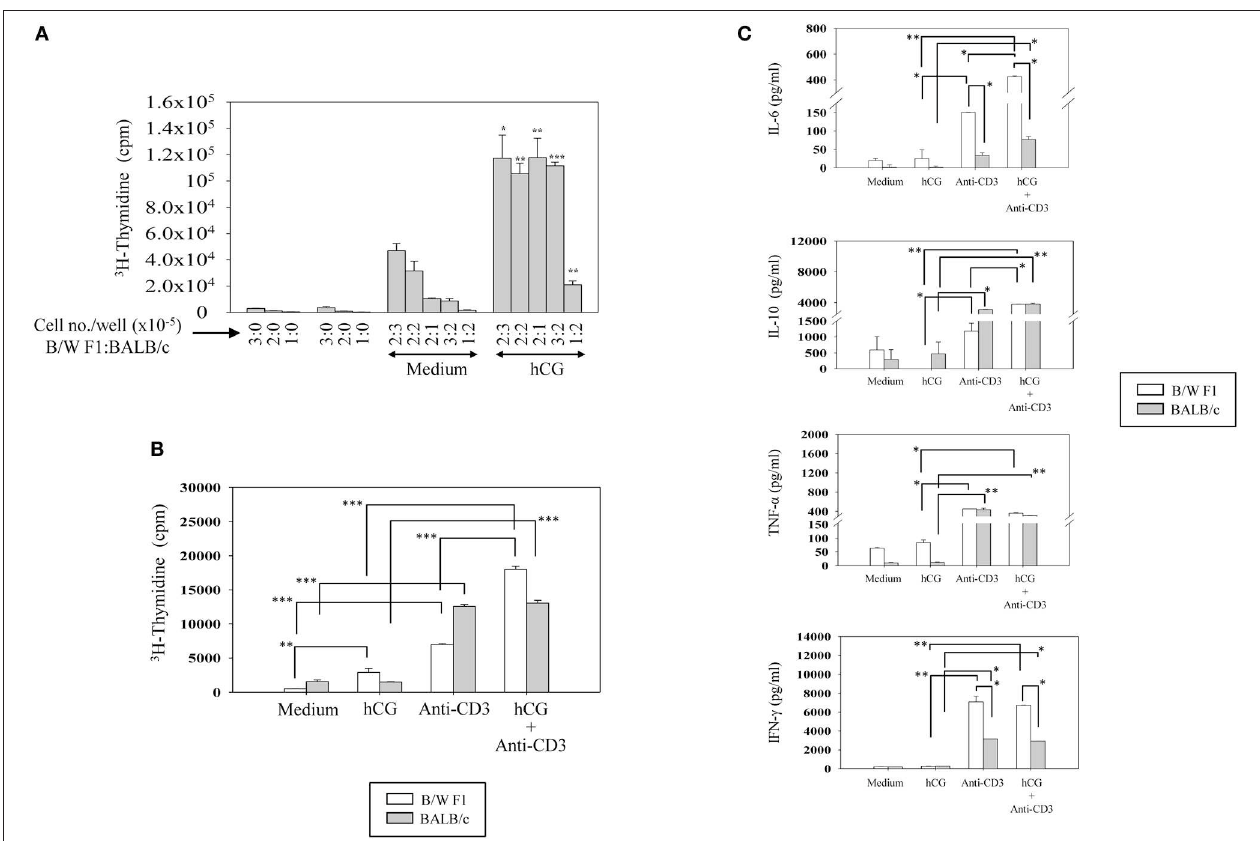
FIGURE 4 | Effect of hCG on leucocyte proliferative and cytokine responses. (A) Effect of hCG on alloreactive proliferative responses. Spleen cells (at the indicated numbers) from B/W F1 and BALB/c mice, dispensed in varying ratios (enumerated as B/W F1:BALB/c), were co-cultured in the presence of hCG. Bars represent arithmetic means ± SEM (from four independent experiments) of 3 H-thymidine incorporation. * p < 0.05, ** p < 0.01, *** p < 0.001 vs. corresponding cultures not containing hCG. (B) Effect of hCG on anti-CD3 induced proliferative responses. Splenocytes isolated from BALB/c and B/W F1 mice were incubated with hCG and anti-CD3 antibodies alone and in combination. Bars represent arithmetic means ± SEM (from three independent experiments) of 3 H-thymidine incorporation. ** p < 0.01, *** p < 0.001. (C) Effect of hCG on cytokine seceretion by splenocytes. Splenocytes isolated from BALB/c and B/W F1 mice were stimulated with hCG and anti-CD3 antibodies alone and in combination. Bars represent arithmetic means ± SEM from three independent experiments. * p < 0.05, ** p <